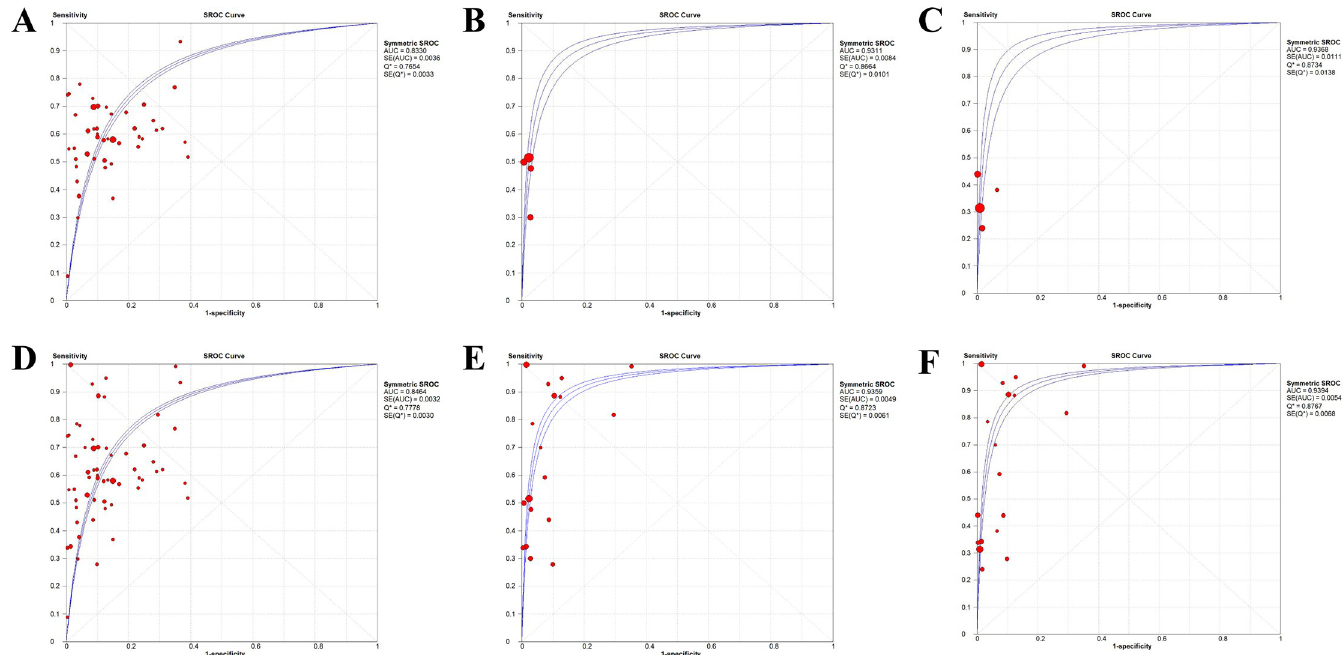
Fig 5. Summary receiver operating characteristic curves (SROC). (A). SROC curve for AFP in 20–100 ng/mL. (B). SROC curve for AFP in 200 ng/mL. (C). SROC curve for AFP in 400 ng/mL. (D) SROC curve for AFP in 20–100 ng/mL combined with ultrasound. (E) SROC curve for AFP in 200 ng/mL combined with ultrasound. (F) SROC curve for AFP in 400 ng/mL combined with ultrasound.